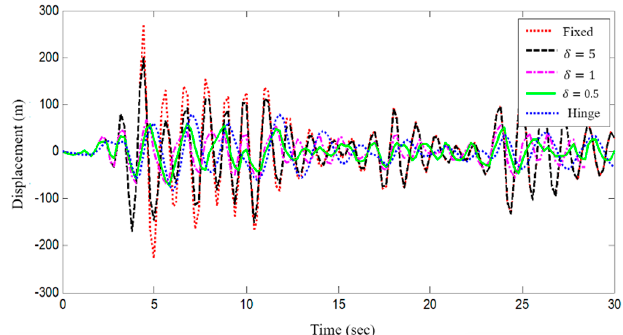
Figure 10. Time history of base shear.